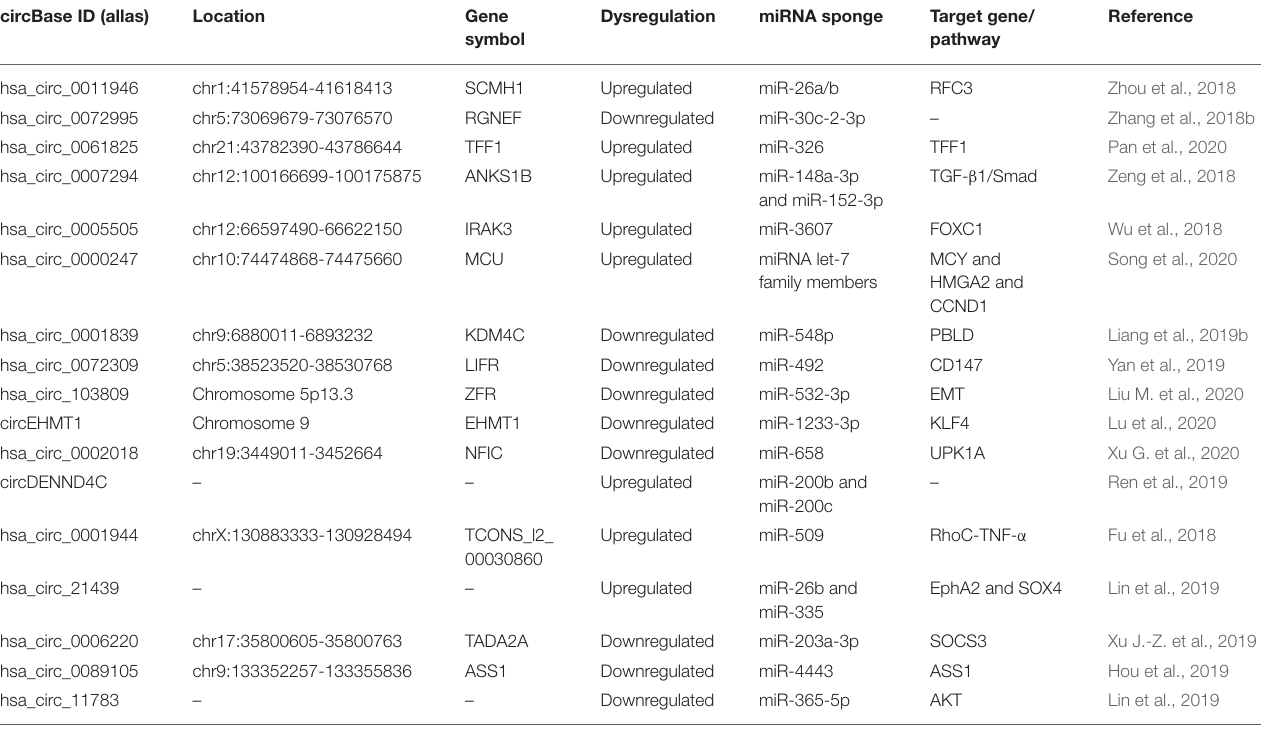
TABLE 2 | The dysregulated circRNAs and their mechanisms in breast cancer metastasis. circBase ID